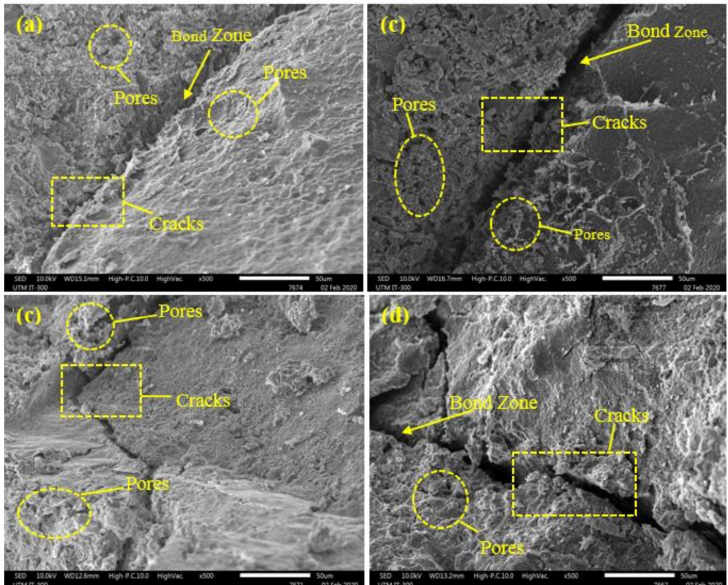
Figure 14. SEM image of modified rubberized concretes exposed to elevated temperatures ( a ) RFC 5 specimen at 500 ◦ C ( b ) RFC 5 specimen at 900 ◦ C ( c ) RFC 30 specimen at 500 ◦ C ( d ) RFC 30 specimen at 900 ◦